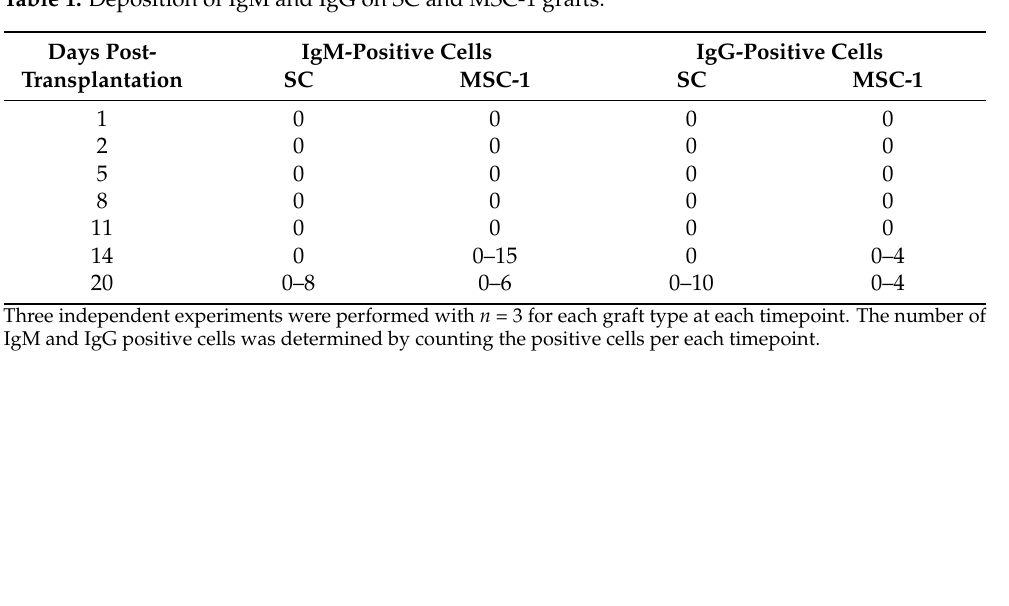
Table 1. Deposition of IgM and IgG on SC and MSC-1